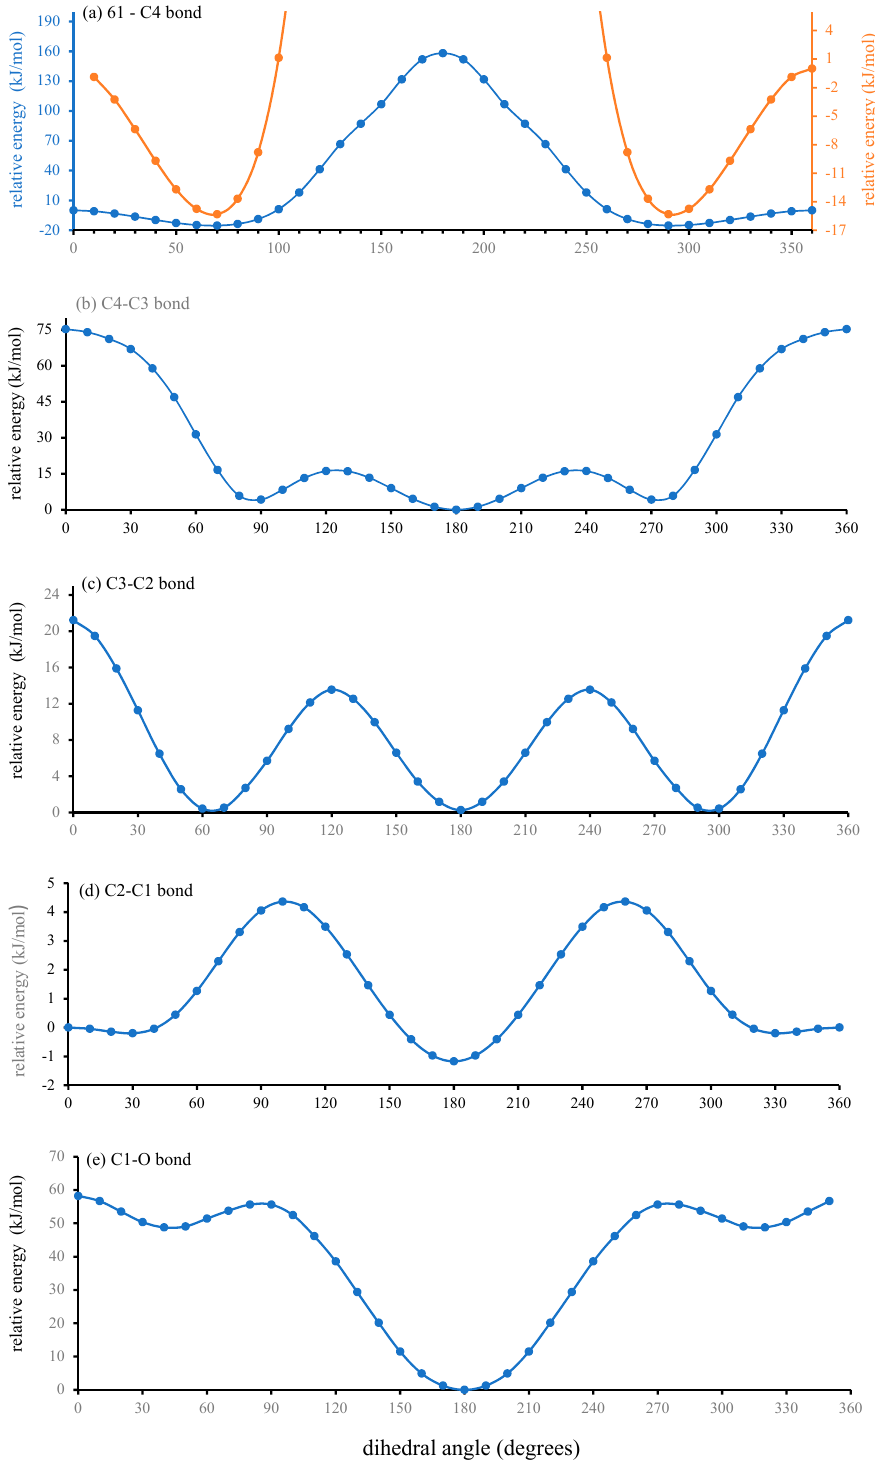
Figure 5. Plots of relative electronic energy as a function of the ( a ) Ph C1-C61-C4-C3 ( b ) C61-C4-C3-C2, ( c ) C4-C3-C2-C1, ( d ) C3-C2-C1-O and ( e ) C2-C1-O-Me dihedral angles (i.e., for rotation about the C61C4, C4 ‐ C3, C3 ‐ C2, C2 ‐ C1 and C1 ‐ O bonds, respectively).